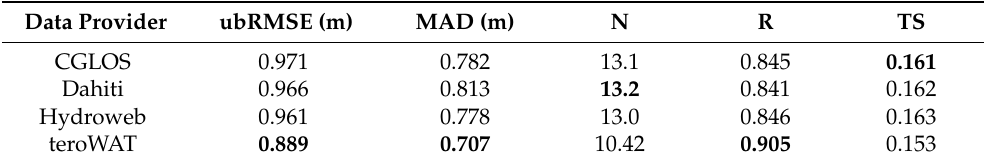
Table 4. Averaged metrics of VSMs for 3 in situ stations (Kirango, Koulikoro, Umaisha) in West Africa for comparison between CGLOS, Dahiti, Hydroweb and teroWAT data providers. Bold values represent the best statistically significant